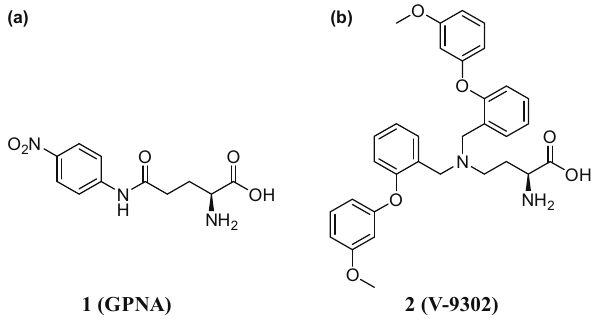
Figure 3: Structure of GPNA ( a ) and V - 9302 ( b )